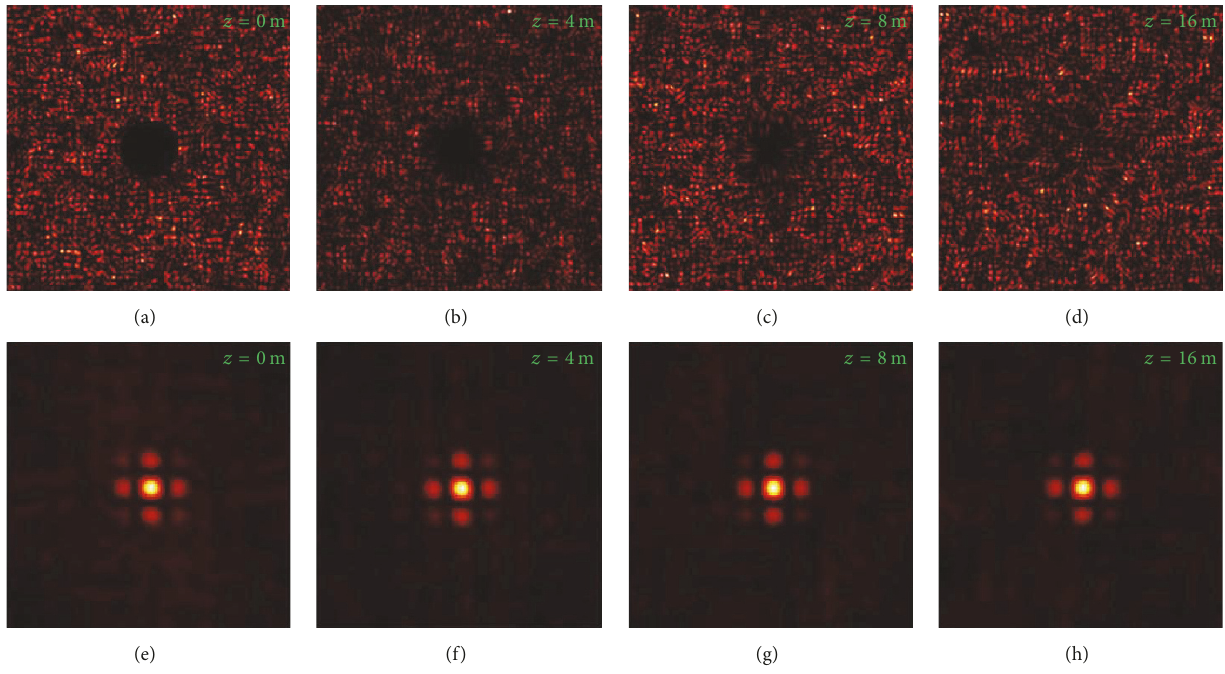
Figure 3: (a)–(d) The simulation of speckle pattern at different propagating distances with 𝑅 = 5 mm, 𝛿 = 6 mm, and 𝑛 = 1 . (e)–(h) corresponding to the distribution of the